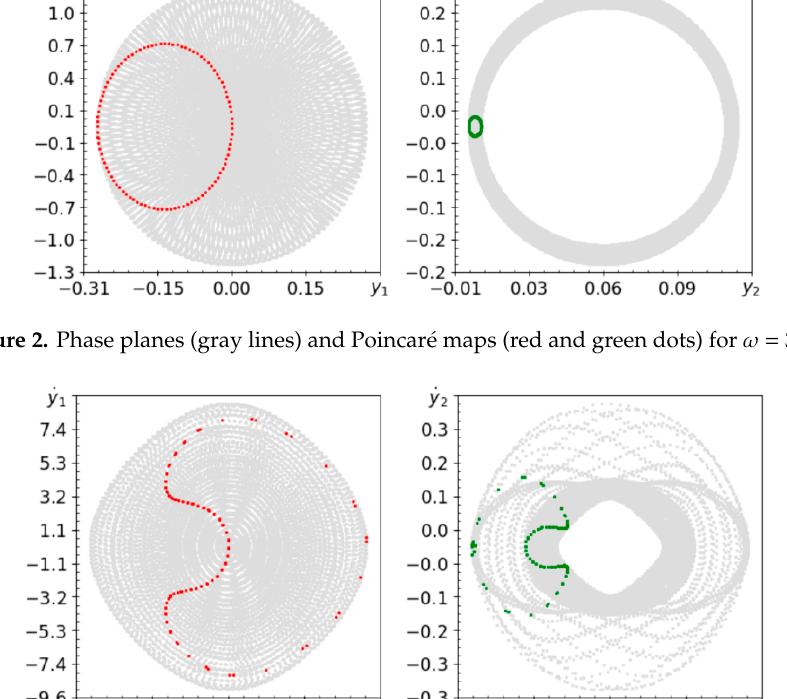
Figure 4. Phase planes (gray lines) and Poincaré maps (red and green dots) for (cid:2033) = 7.24 .